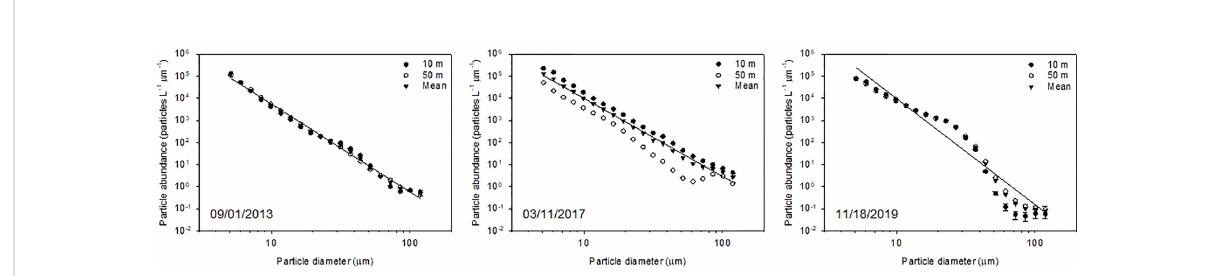
FIGURE 3 Particle size number distribution following the power-law model (Eq. 1) using double logarithmic transformation in the size range of 5.2 – 119 m m at depths of 10 and 50 m and averaged across the euphotic zone (see details in the main text) in the subtropical gyre area. Error bars indicate